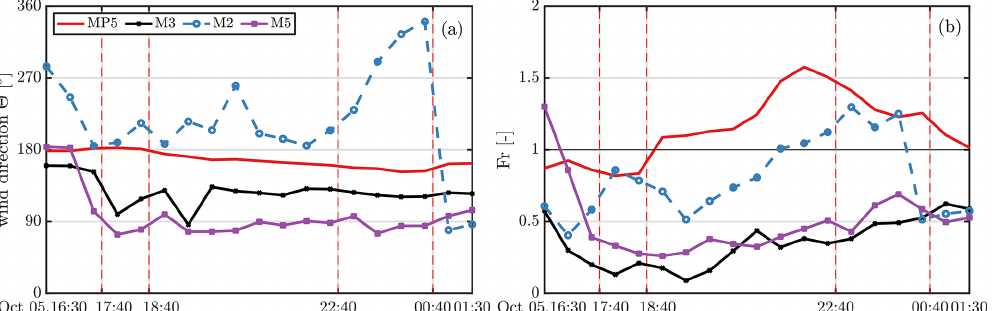
Figure 10. Time series of wind direction (a) and Froude number (b) during the hydraulic jump case. The vertical dashed lines represent the snapshots of Fig.